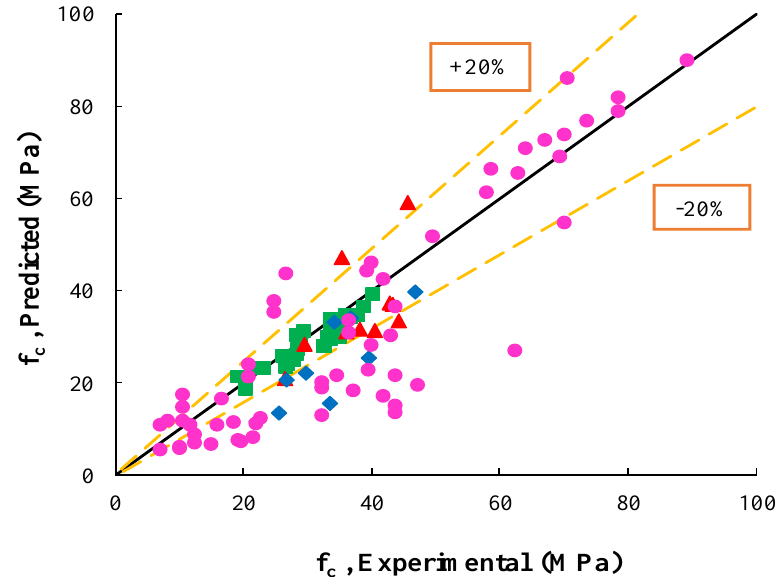
Figure 21. Comparison of the proposed model with experimental values of other researchers in literature and the present study.